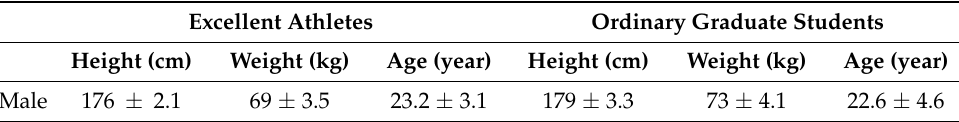
Table 1. Basic information of subjects.